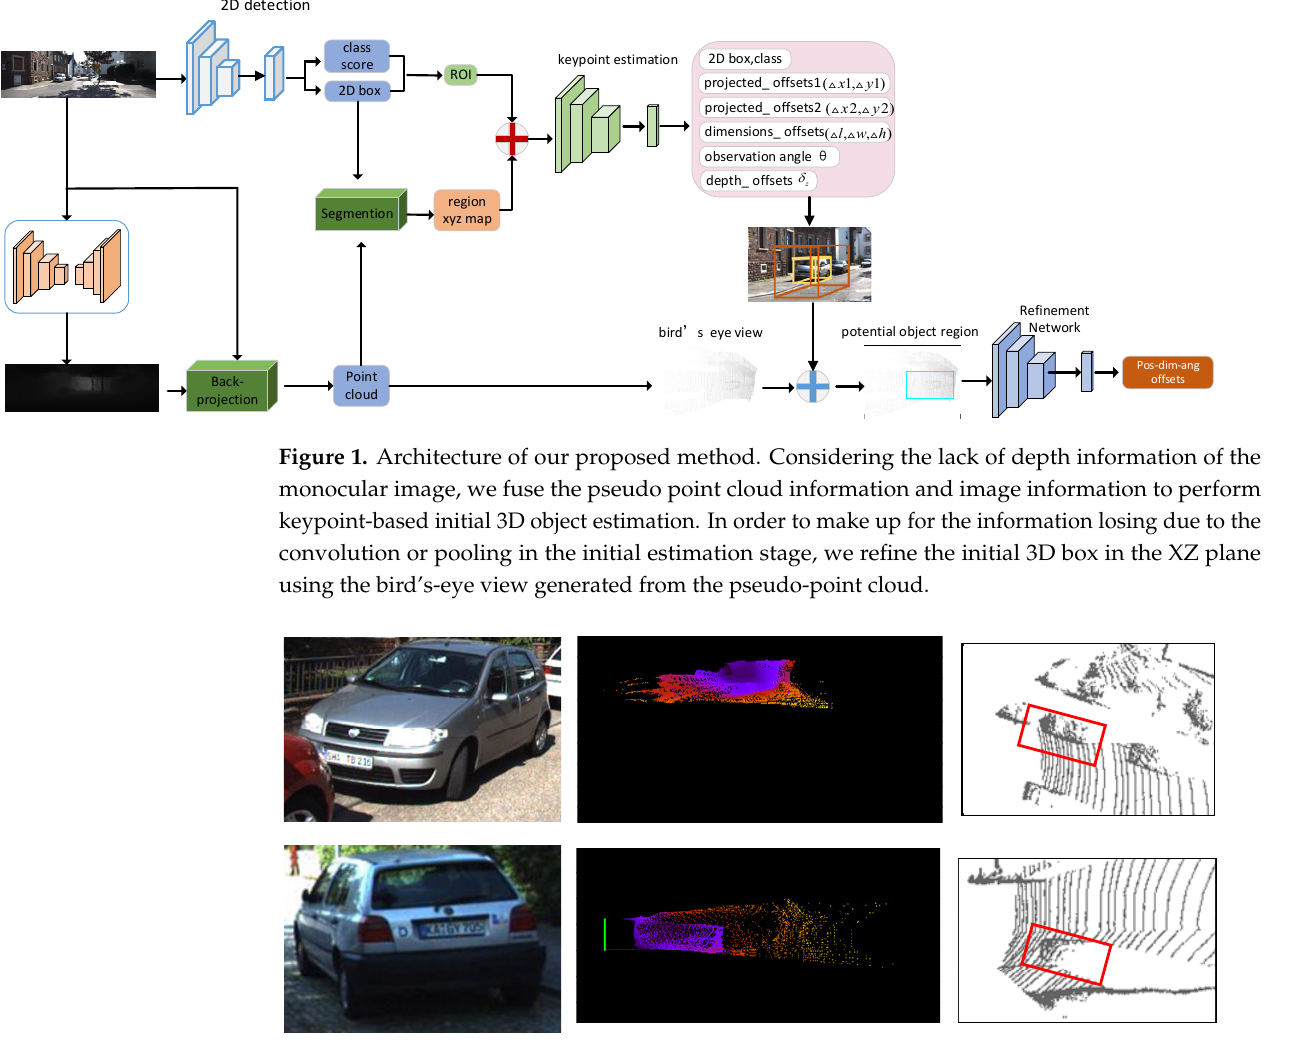
Figure 2. Pseudo-multimodal data used for fusion in our algorithm. From left to right, there are image patches, the corresponding region pseudo-lidar point cloud, and the corresponding panoramic bird’s-eye view. The area surrounded by the red box in the bird’s-eye view is where the object is located.